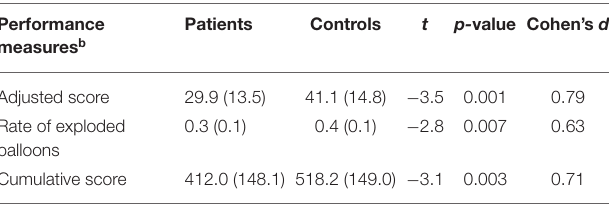
TABLE 2 | Comparison of risk-taking performance measures between patients and controls a .